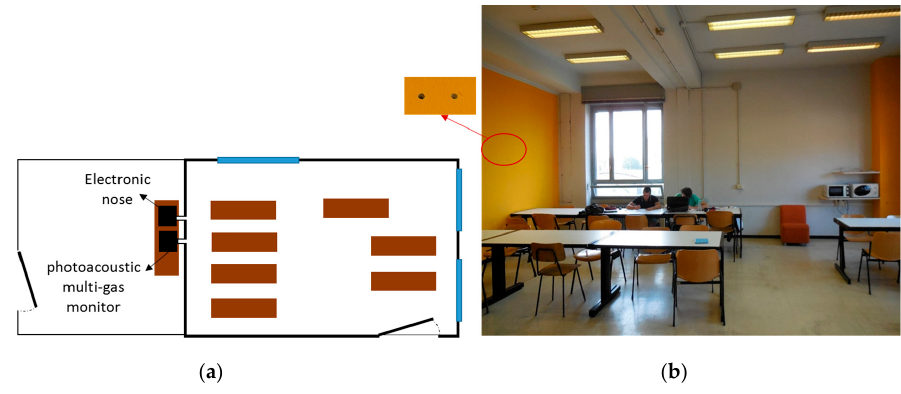
Figure 2. The university study room monitored: Scheme of the study room and the link with monitoring system ( a ); picture of the study room ( b ).